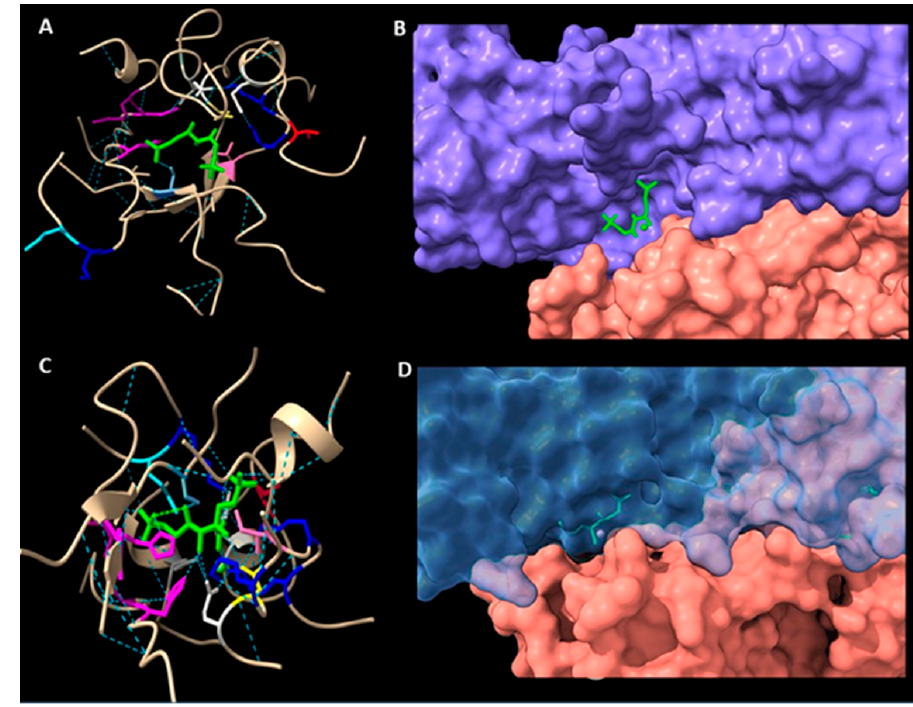
Figure 3. Active site residues arrangement ( A , C ) and molecular surface ( B , D ) in the Symbodinium Rubisco modelled on the R. rubrum enzyme ( A , B ) and R. palustris ( C , D ). Amino acids of the active site are coloured identically. Note the presence of a ligand molecule (green sticks), which is RuBP in the R. rubrum based structure and CABP in the model based on R. palustris .